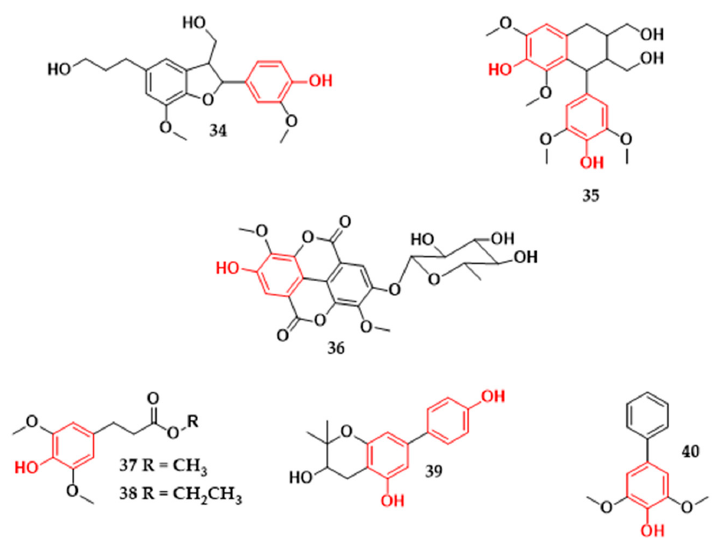
Figure 8. Other classes of phenolic compounds with antibacterial activity isolated from plants in Brazil. Dihydrodehydrodiconiferyl alcohol ( 34 ), lyoniresinol ( 35 ), Acid 3,3 ′ -dimethoxyellagic acid-4- O- α -rhamnopyranoside ( 36 ), (E)-methyl-4-hydroxy-3,5-dimethoxycinnamate ( 37 ), (E)-ethyl-4-hydroxy-3,5-dimethoxycinnamate ( 38 ), 2,2-dimethyl-3,5-dihydroxy-7-(4-hydroxyphenyl) chromane ( 39 ), aucuparin ( 40